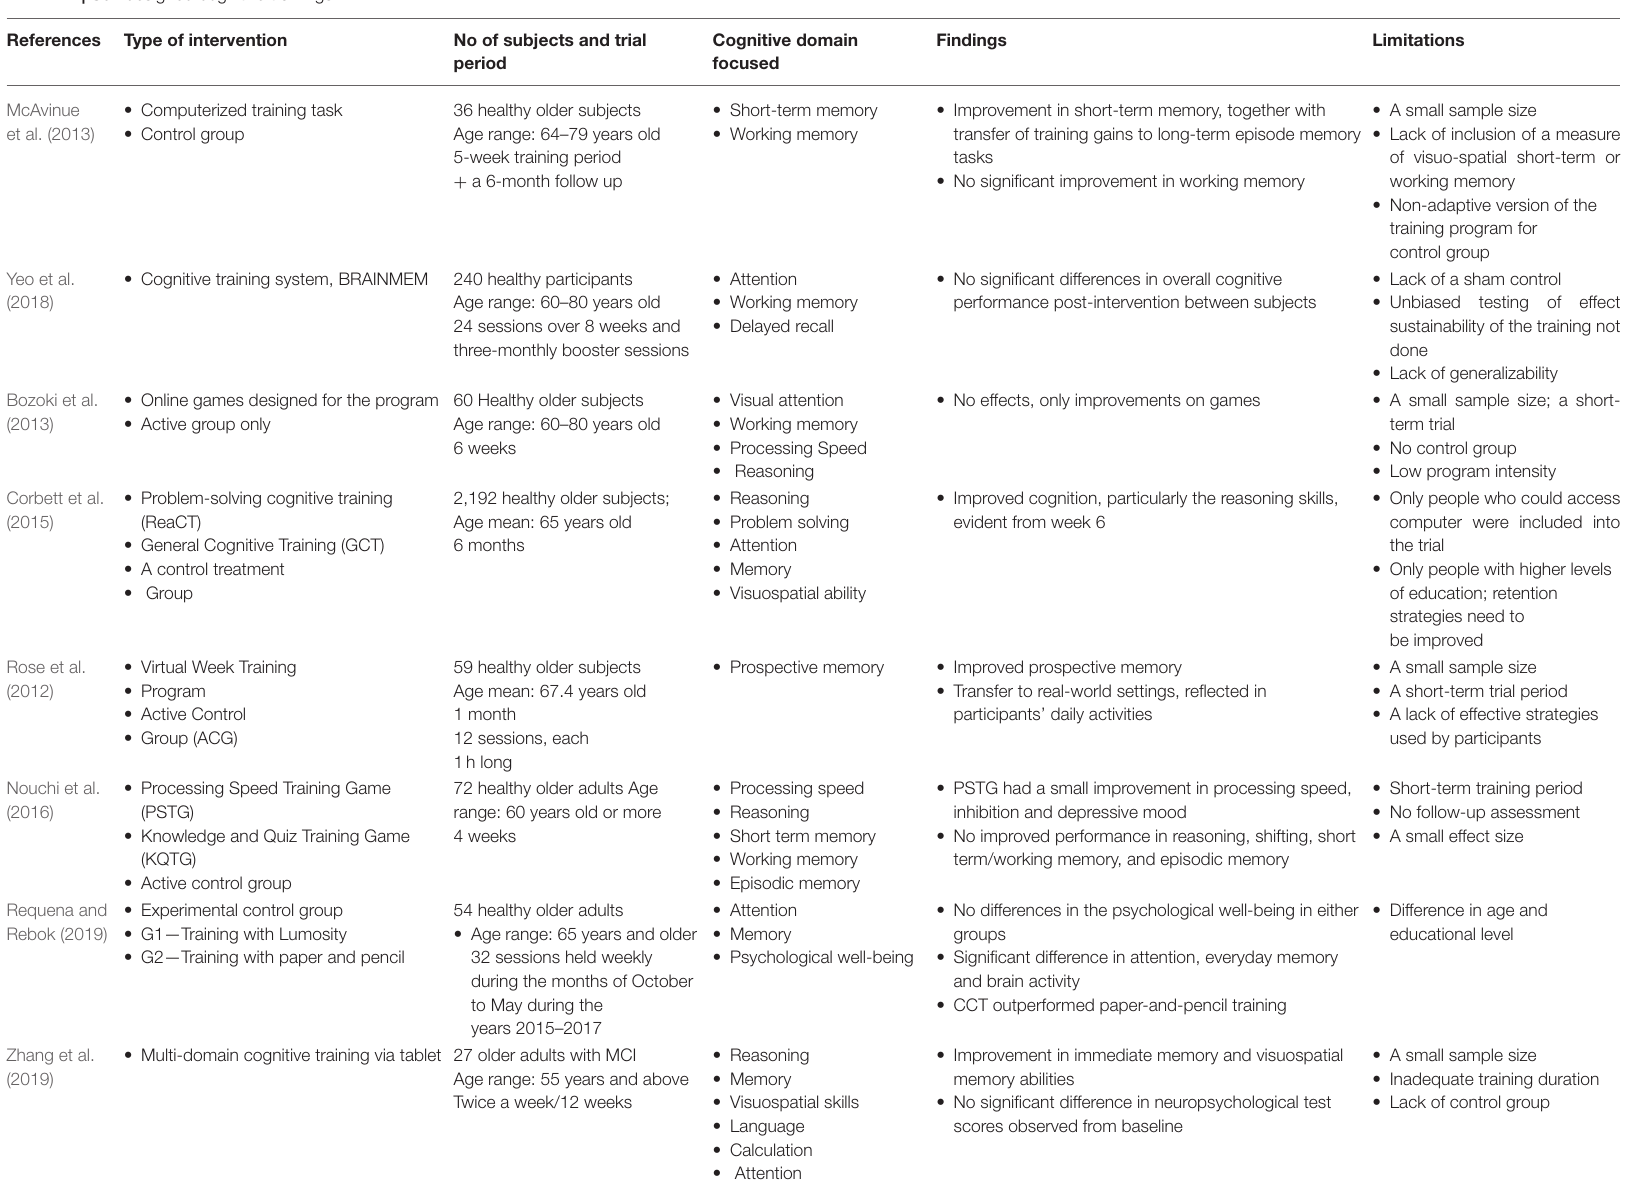
TABLE 2 | Self-designed cognitive